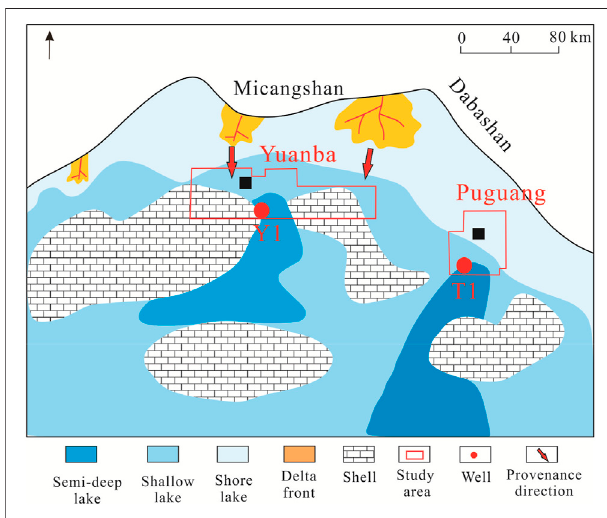
FIGURE 12 | Distribution of sedimentary facies of the J 1 da strata in northeast Sichuan Basin (modi fi ed by Zhang, 2018).